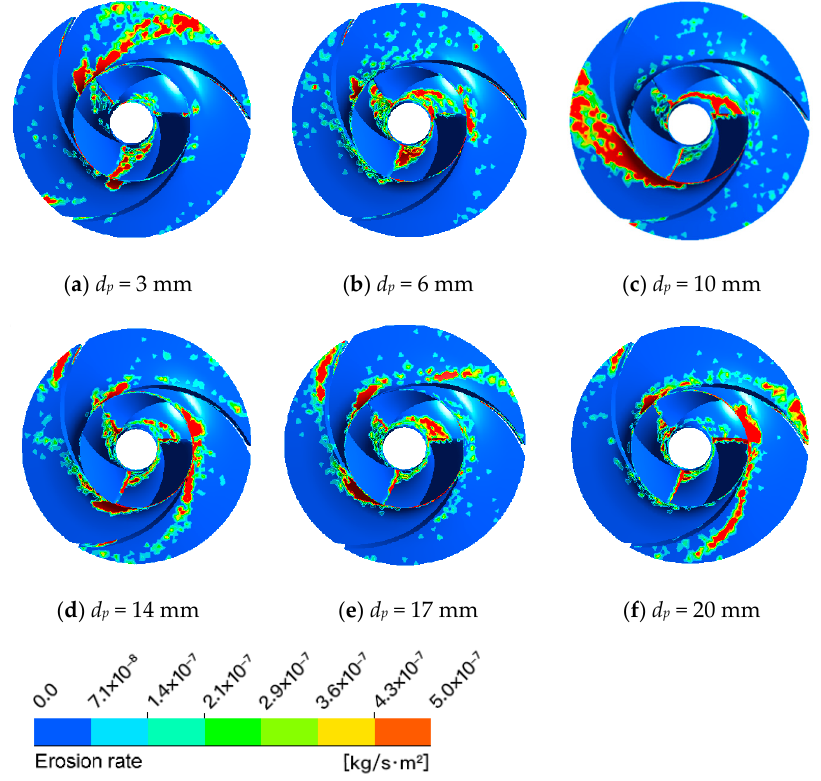
Figure 8. Wear distribution on the impeller surface.